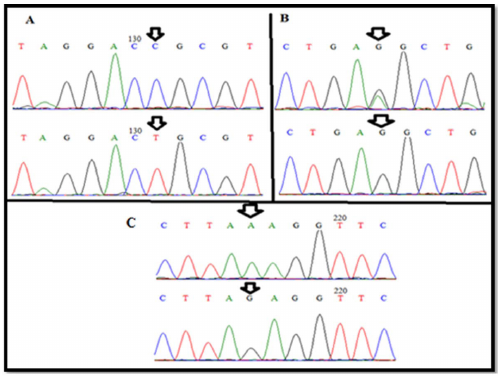
Fig. 2. Wild-type and new variant(A)T(114)C, (B)G(129) R and (C)G(199)A of exon I GDF-9 gene. Table 1. Type of substitution of exon I GDF-9 gene in Awassi ewes Location of Nucleotide Amino acid